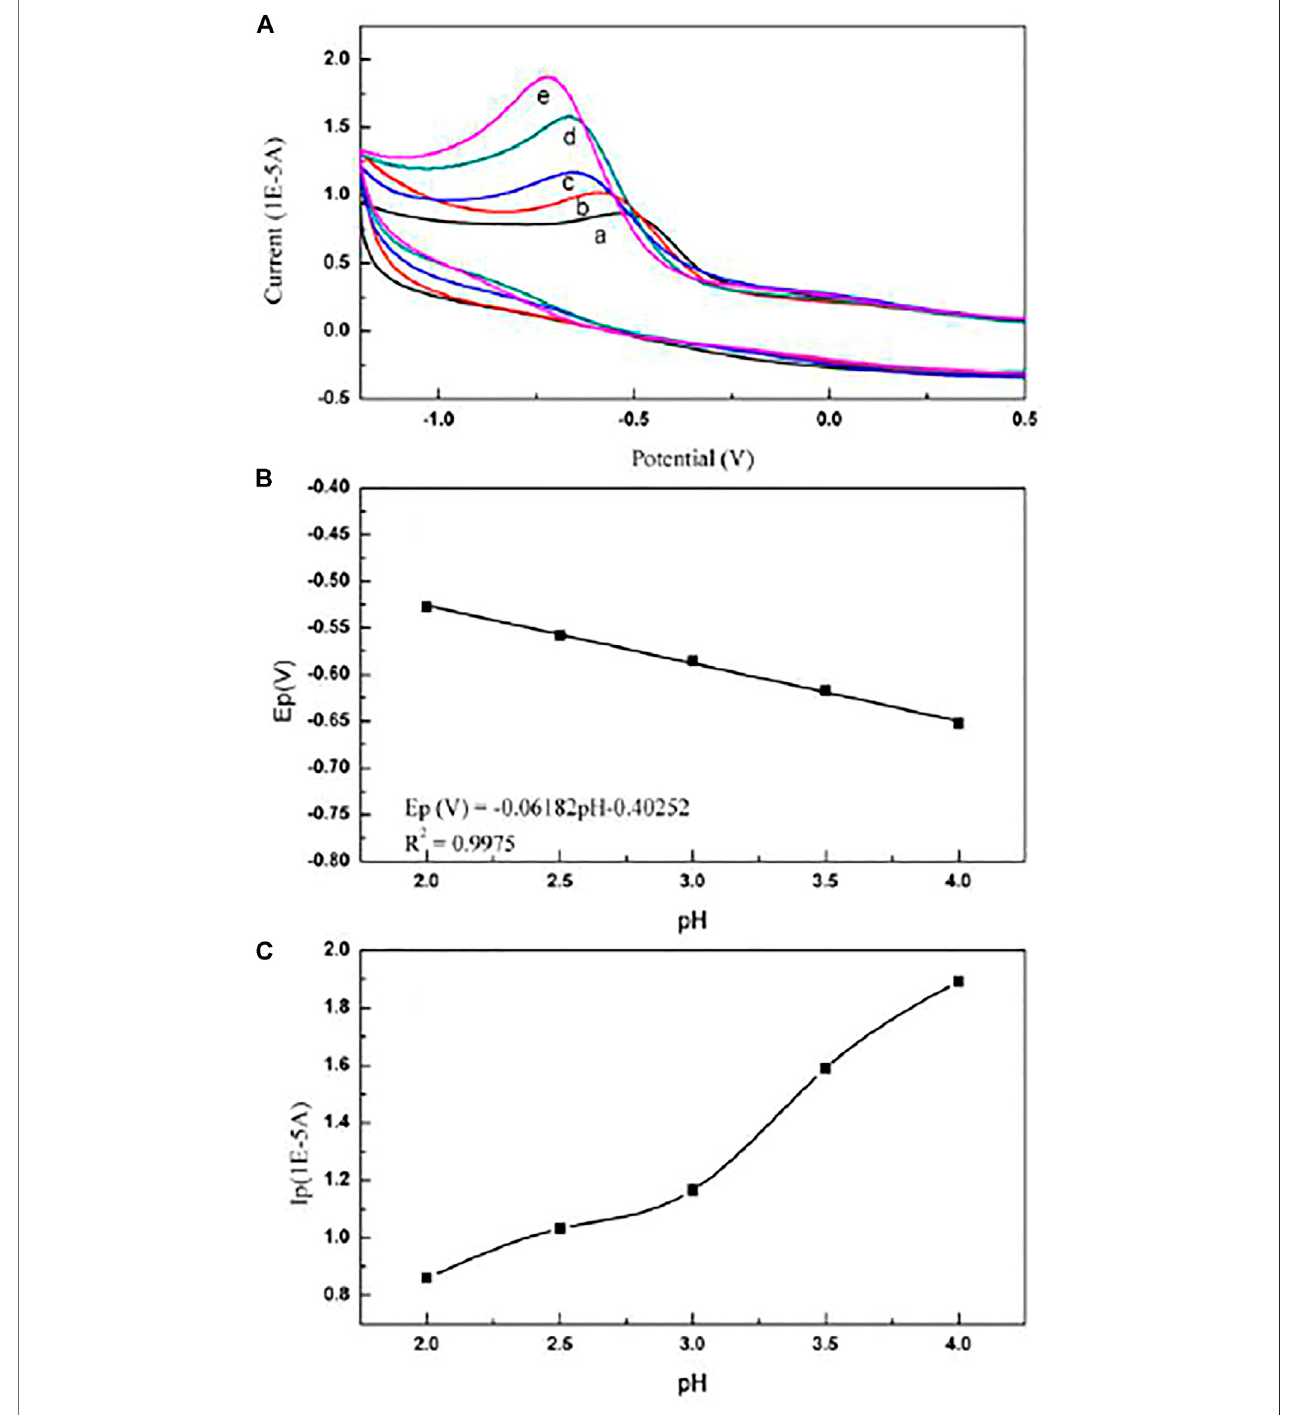
FIGURE 3 | (A) Cyclic voltammogram of paclitaxel in electrolytes with different pH: (a) pH = 2.0; (b) pH = 2.5; (c) pH = 3.0; (d) pH = 3.5; (e) pH = 4.0. (B) DependenceofpHonthepotentialEp(V)ofpaclitaxel.Scanrateis50 mV/s.Theconcentrationofpaclitaxelis1×10 − 5 mol/L. (C) DependenceofpHonthecurrentIp(V) of paclitaxel. Scan rate is 50 mV/s. The concentration of paclitaxel is 1 × 10 − 5 mol/L. of three parts, the working electrode is a glassy carbon electrode order to improve the reproducibility and sensitivity of the peak (3 mm in diameter), the counter electrode is a platinum electrode, current, the electrode was cleaned fi ve times in ethanol using and the reference electrode is a saturated calomel electrode. In cyclic voltammetry before each measurement.